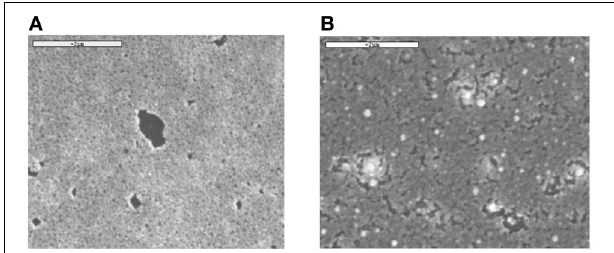
FIGURE 1 | SEM micrographs of: (A) A Pt(Ni) coating of a 47% Pt-53%Ni atom composition, prepared after the immersion of Ni electrodeposits on GC (deposition charge density of 380mC cm − 2 ) in a 0.1M HCl + 5 × 10 − 5 M K 2 PtCl 6 solution, followed by electrochemical conditioning in the − 0 . 3 ± 0 . 6 V vs. SCE potential range; (B) A Pt-Ru(Ni) coating of a 37% Pt-12% Ru-51%Ni atom composition, prepared from Ni electrodeposits